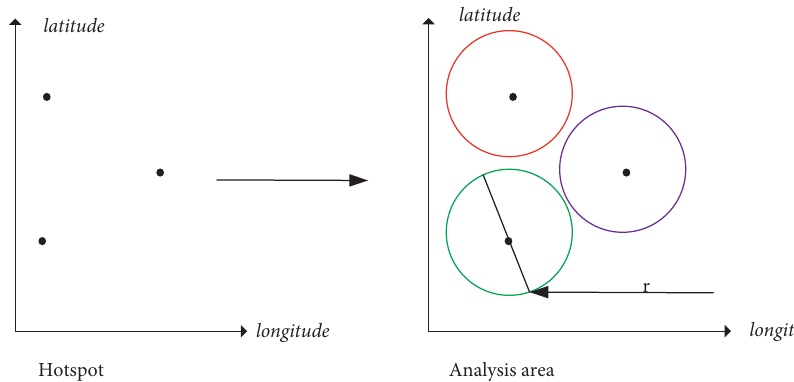
Figure 4: The representation for establishing spatial riding characteristic analysis